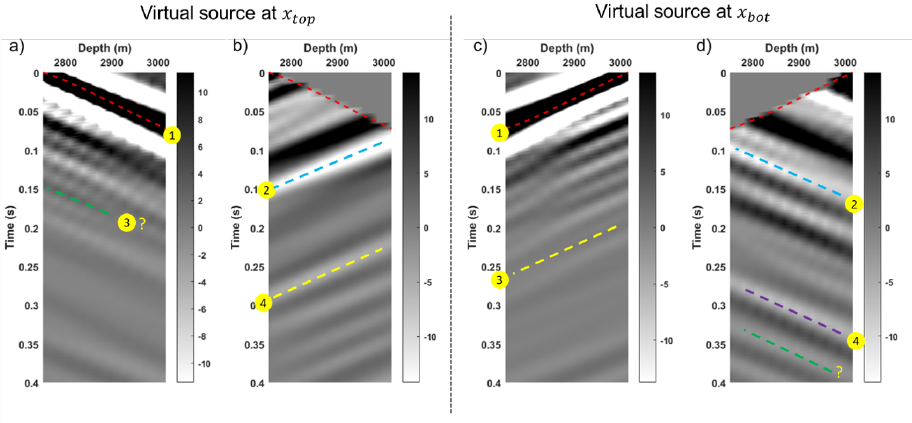
Figure 17. Interferometry using noise data. ( a , b ) show the estimated transmission and reflection response for a virtual source at the top geophone. ( c , d ) are the estimated transmission and reflection response for a virtual source at the bottom